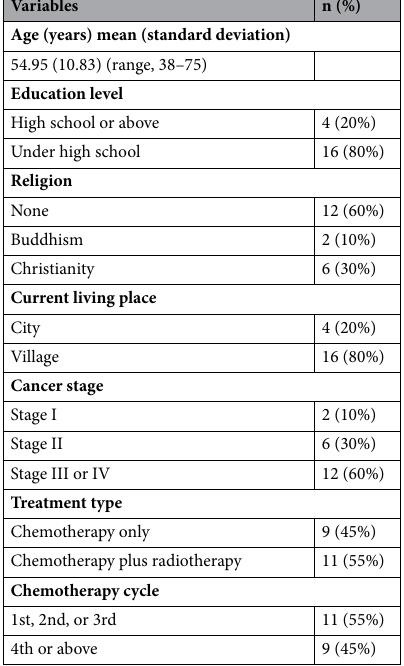
Table 1. Demographic characteristics of the participants (N = 20).